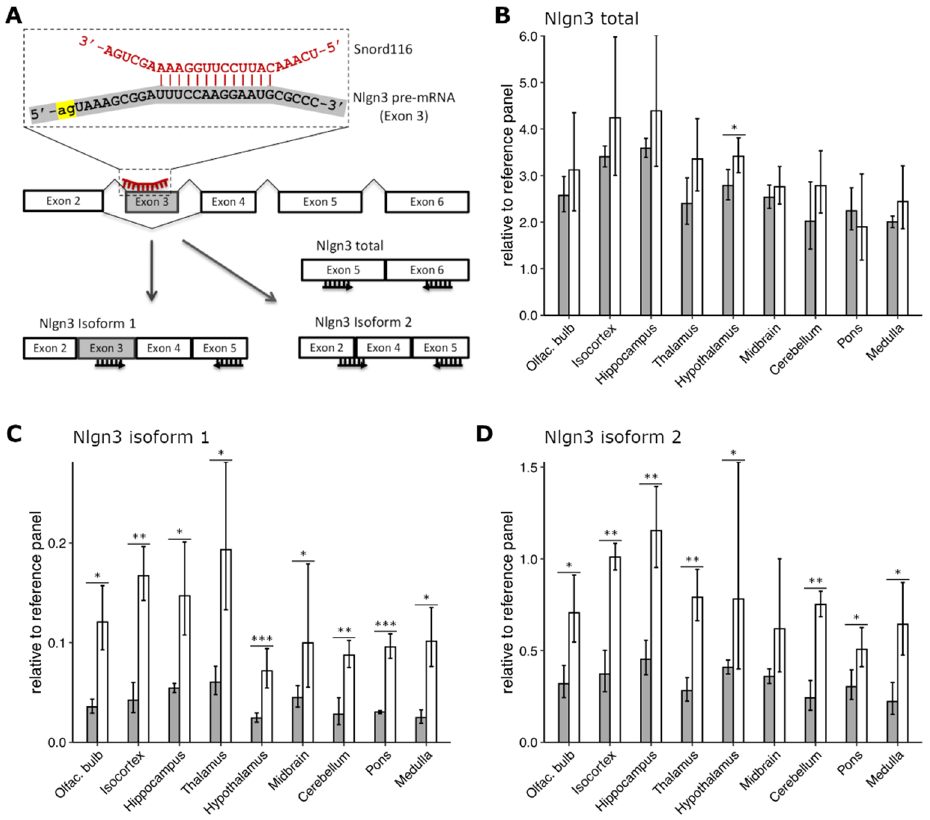
Figure 4. Effect of Snord116 knock-out on expression and alternative splicing of Nlgn3 in mouse brain. ( A ) Putative complementarity of Snord116 (red) with exon 3 of Nlgn3 pre-mRNA (gray). 3 ′ - splicing site (acceptor) indicated in yellow. Schematic representation of alternative splicing of Nlgn3 mRNA into isoform 1 (including exon 3) and isoform(s) 2 (excluding exon 3), respectively. Forward and reverse primers for the designed RT-qPCR assays are depicted as black arrows under the exons. ( B ) Expression levels of total Nlgn3, ( C ) Nlgn3 isoform 1, and ( D ) Nlgn3 isoform 2 relative to the reference gene panel in nine brain regions of WT and PWScr m+/p − mice are depicted with gray and white bars, respectively, as Mean ± SD of three biological replicates (six for WT hypothalamus); * p ≤ 0.05, ** p ≤ 0.01, *** p ≤ 0.001, unpaired two-samples t -test.